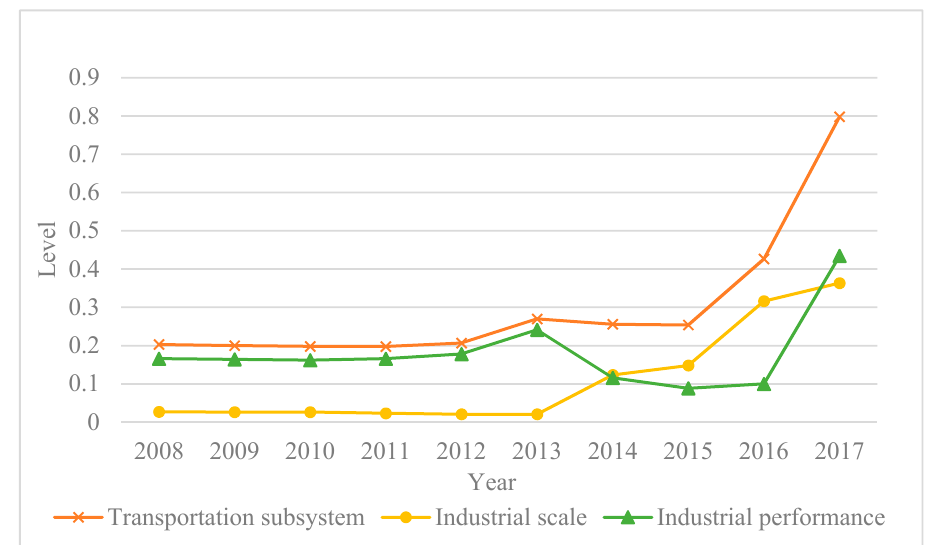
Figure 4. Trends of the comprehensive levels in transportation subsystem.